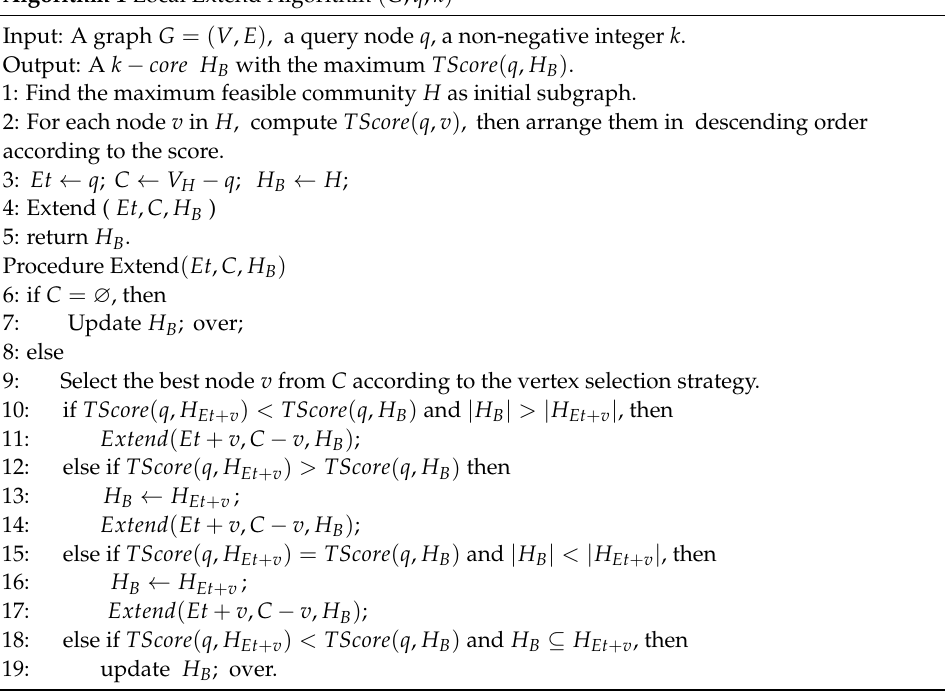
Algorithm 1 Local Extend Algorithm ( G , q , k